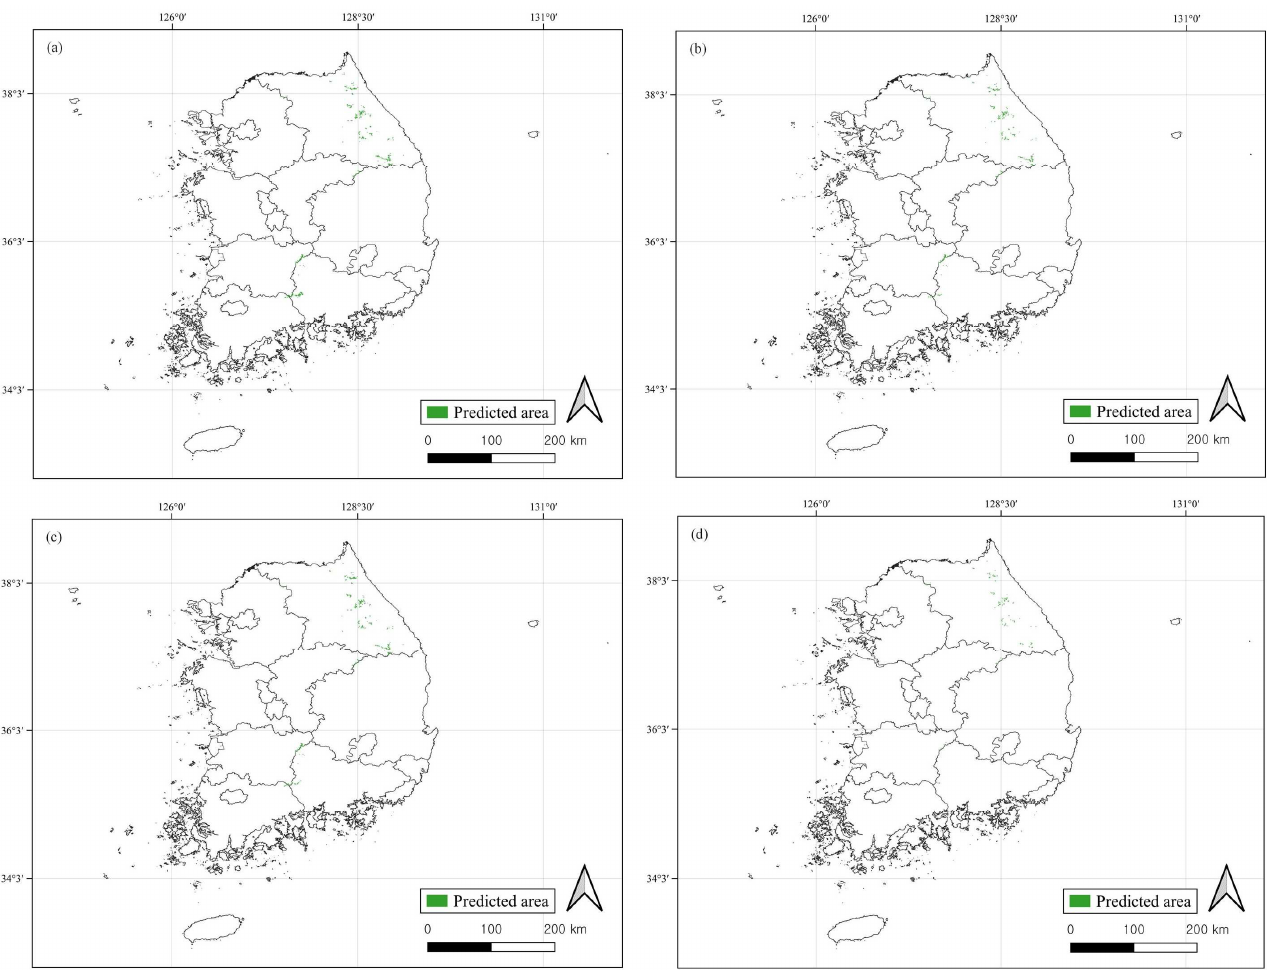
Figure 5. The future potential distribution of Abies nephrolepis based on SSP scenario. ( a ) Distribution areas of Abies nephrolepis in 2050 (SSP2-4.5). ( b ) Distribution areas of Abies nephrolepis in 2050 (SSP5-8.5). ( c ) Distribution areas of Abies nephrolepis in 2070 (SSP2-4.5). ( d ) Distribution areas of Abies nephrolepis in 2070 (SSP5-8.5).